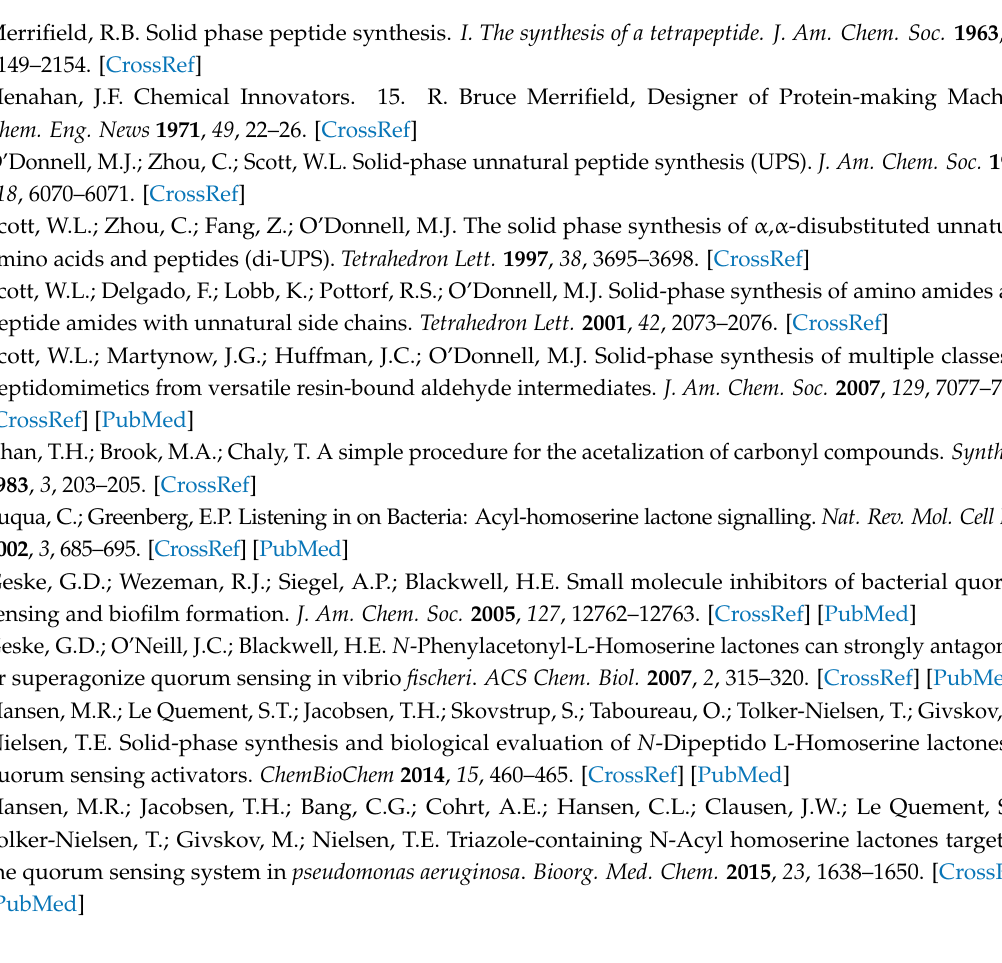
Figure S42. Carbon-13 NMR Spectrum of β - 35c in CDCl 3 , Figure S43. Proton NMR Spectrum of α - 35c in CDCl 3 , Figure S44. Carbon-13 NMR Spectrum of α - 35c in CDCl 3 , Figure S45. Proton NMR Spectrum of β - 36a in CDCl 3 , Figure S46. Carbon-13 Spectrum of β - 36a in CDCl 3 , Figure S47. Proton NMR Spectrum of α - 36a in CDCl 3 , Figure S48. Carbon-13 NMR Spectrum of α - 36a in CDCl 3 , Figure S49. Proton NMR Spectrum of β - 36b in CDCl 3 , Figure S50. Carbon-13 NMR Spectrum of β - 36b in CDCl 3 , Figure S51. Proton NMR Spectrum of α - 36b in CDCl 3 , Figure S52. Carbon-13 NMR Spectrum of α - 36b in CDCl 3 , Figure S53. Proton NMR Spectrum of α - 36c in CDCl 3 , Figure S54. Carbon-13 NMR Spectrum of α - 36c in CDCl 3 , Figure S55. Proton NMR Spectrum of β - 36c in CDCl 3 , Figure S56. Carbon-13 NMR Spectrum of β - 36c in CDCl 3 , Figure S57. Proton NMR Spectrum of α - 30b in CDCl 3 , Figure S58. Carbon-13 NMR Spectrum of α - 30b in CDCl 3 , Figure S59. Proton NMR Spectrum of β - 30b in CDCl 3 , Figure S60. Carbon-13 NMR Spectrum of β - 30b in CDCl 3 , Figure S61. Proton NMR Spectrum of β - 30c in CDCl 3 , Figure S62. Carbon-13 NMR Spectrum of β - 30c in CDCl 3 , Figure S63. Proton NMR Spectrum of α - 30c in CDCl 3 , Figure S64. Carbon-13 NMR Spectrum of α - 30c in CDCl 3 , Figure S65. Proton NMR Spectrum of α - 37b in CDCl 3 , Figure S66. Carbon-13 NMR Spectrum of α - 37b in CDCl 3 , Figure S67. Proton NMR Spectrum of β - 37b in CDCl 3 , Figure S68. Carbon-13 NMR Spectrum of β - 37b in CDCl 3 . Figure S69. Proton NMR Spectrum of (Fmoc-Ala) 2 O in CDCl 3 with Diisopropylurea (DIU), Figure S70 . Proton NMR Spectrum of Boc-Cys(Trt)-Leu-OMe in CDCl 3 , Figure S71. Carbon-13 NMR Spectrum of Boc-Cys(Trt)-Leu-OMe in CDCl 3